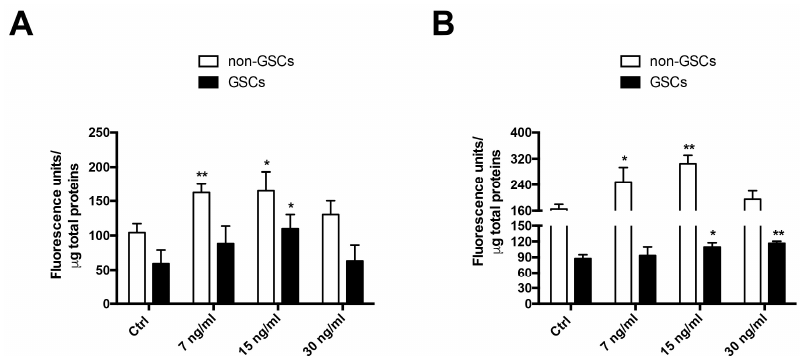
Figure 2. Effect of FK506 on MRP1 activity in U87MG and C6 cells. Cells were treated with FK506 (7, 15, and 30 ng/mL) for 24 h. Activity was measured by MRP1 fluorescent substrate Carboxyfluorescein Diacetate (CFDA) accumulation. The graphs represent fluorescence units normalized by protein concentration in U87MG ( A ) and C6 ( B ) cells. White bars represent non-GSCs and black bars represent GSCs. Graphs represent the mean ± S.D. * p < 0.05 and ** p < 0.01 versus the control condition (Ctrl). n = 6. Int. J. Mol. Sci. 2018 , 19 , x FOR PEER REVIEW